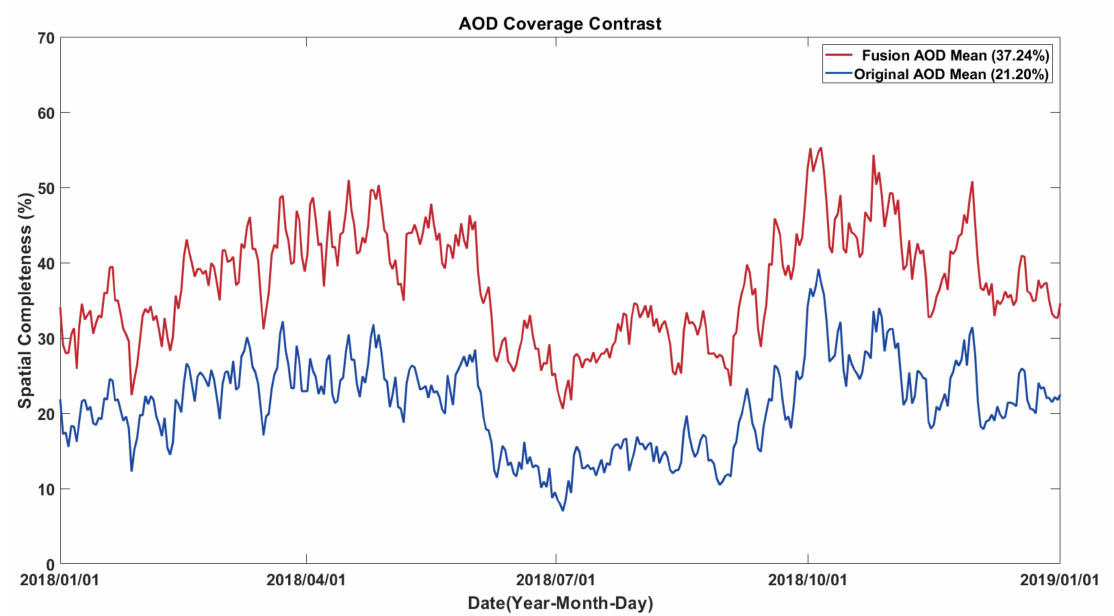
Figure 3. Time series plot of daily coverage for original (red line) and fused (blue line) MAIAC AOD. The numbers in parentheses represent the averaged AOD coverage.